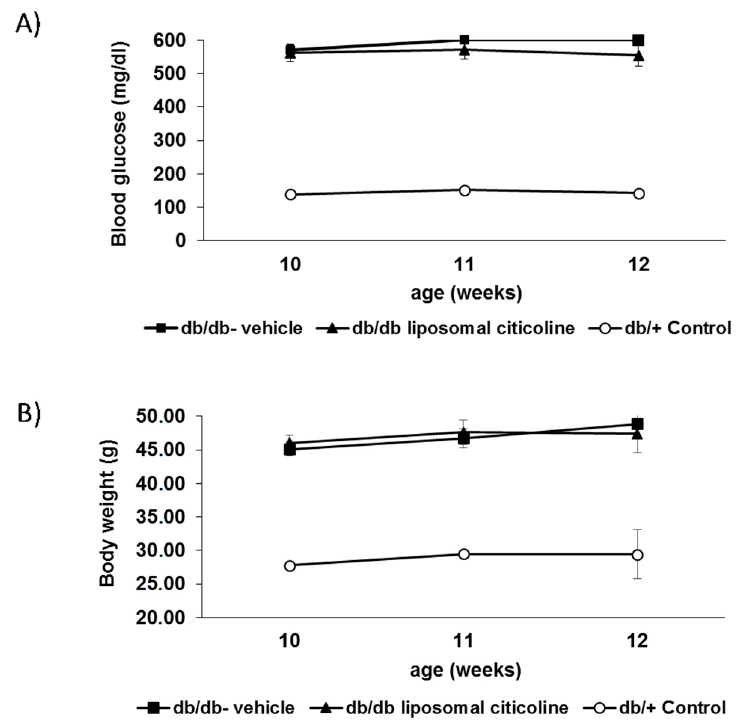
Figure 1. Evolution of blood glucose ( A ) and body weight ( B ) in the experimental groups.